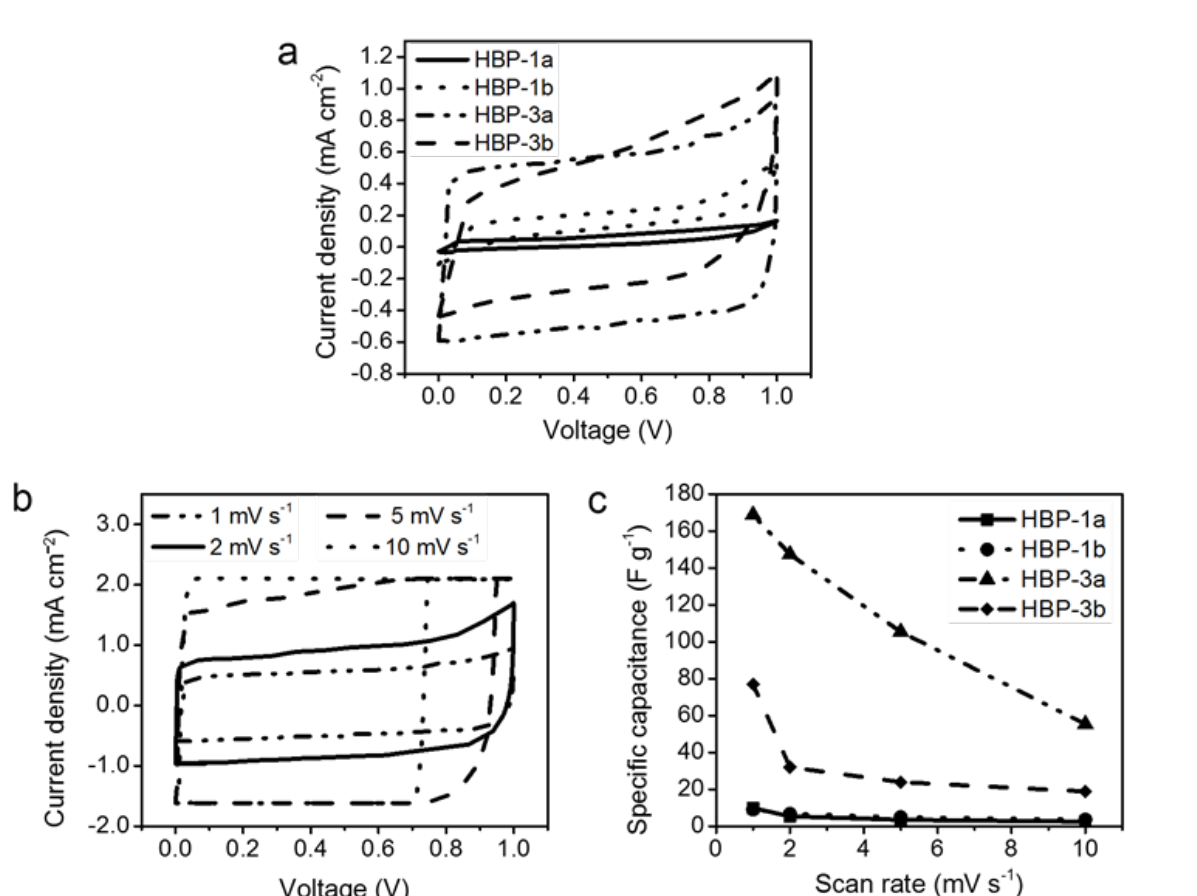
Fig. 5. Electrochemical measurements in a two-electrode system: (a) CV curves from HBP-s samples at a scan rate of 1 mV s -1 ; (b) CV curve from HBP-3a at different scan rates; (c) the specific capacitance from HBP-s samples at different scan